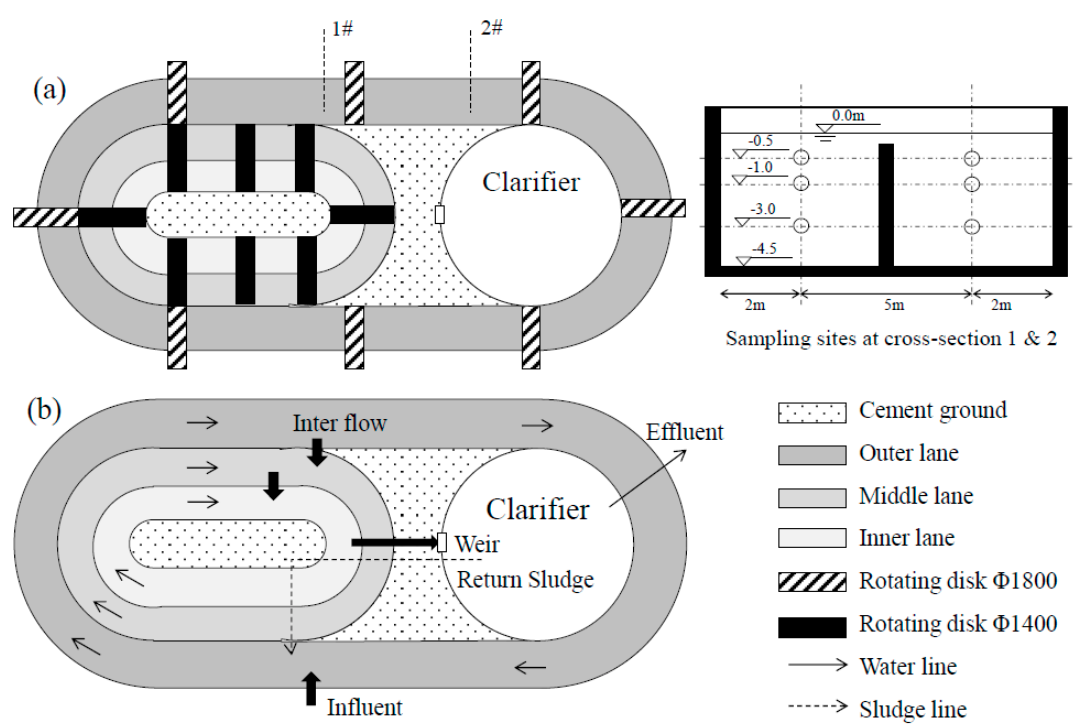
Figure 1. Scheme of an Orbal oxidation ditch and sampling sites. ( a ) Rotating disks on the oxidation ditch and the sampling sites at the cross-section; ( b ) Fluidic directions between the reactors.